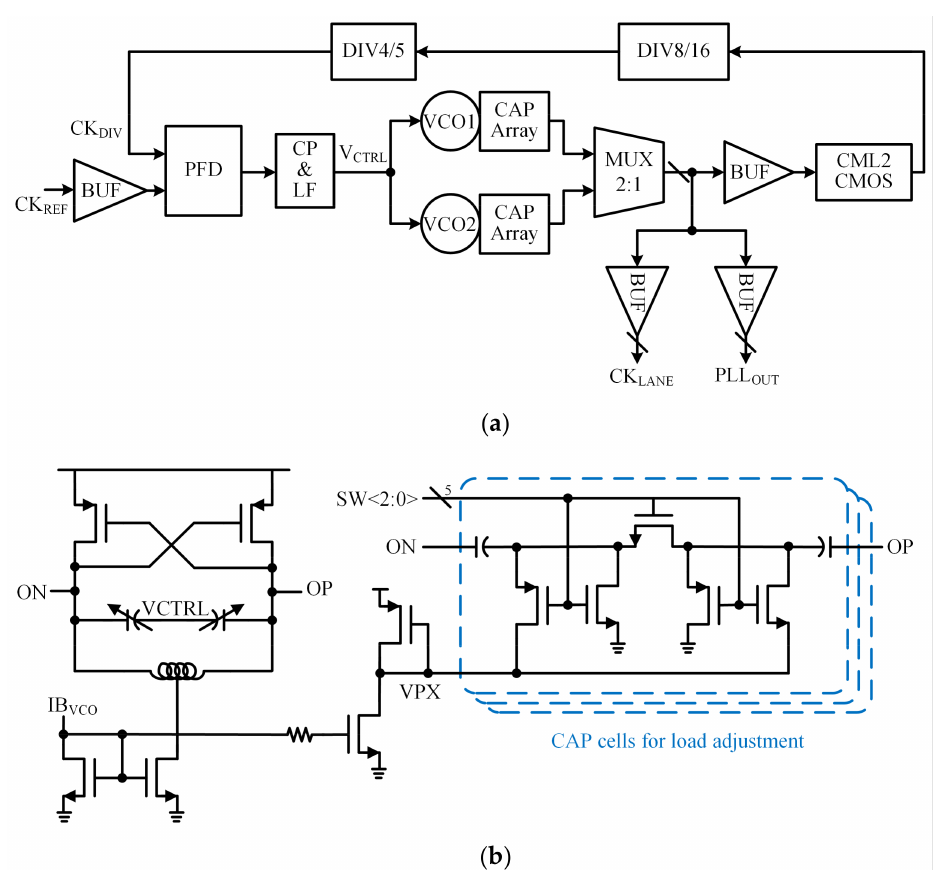
Figure 5. ( a ) The block diagram of the wide-operation-range PLL. ( b ) The designed